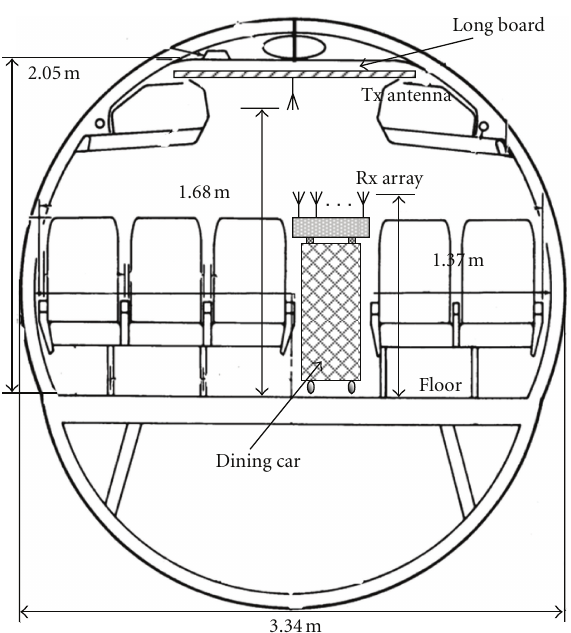
Figure 2: Cross-section of the measurement environment.